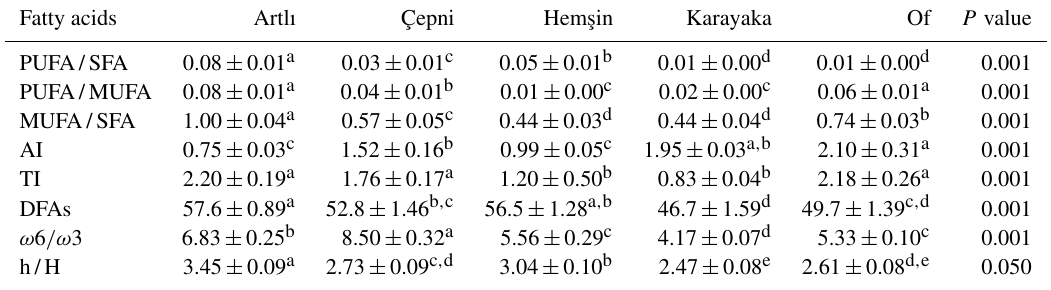
The abbreviations/variables listed in the table are as follows: SFA – saturated fatty acid; MUFA – monounsaturated fatty acid; PUFA – poly unsaturated fatty acid; AI – atherogenic index, calculated as ((C12:0) + 4 × (C14:0) + (C16:0)) / ( (cid:54) MUFA + (cid:54) PUFA); TI – thrombogenic index, calculated as ((C14:0 + C16:0 + C18:0)) / (( 0 . 5 × (cid:80) MUFA) + ( 0 . 5 × (cid:80) PUFAn-6) + ( 3 × (cid:80) PUFAn-3) + ( (cid:80) PUFAn-3) / ( (cid:80) PUFAn-6)); DFAs – desirable fatty acids, calculated as (MUFA + PUFA + C18:0); the (cid:54)ω 6 /(cid:54)ω 3 ratio, calculated as (C18:2 + C18:3 + C20:2 + C20:4 + C22:5 +